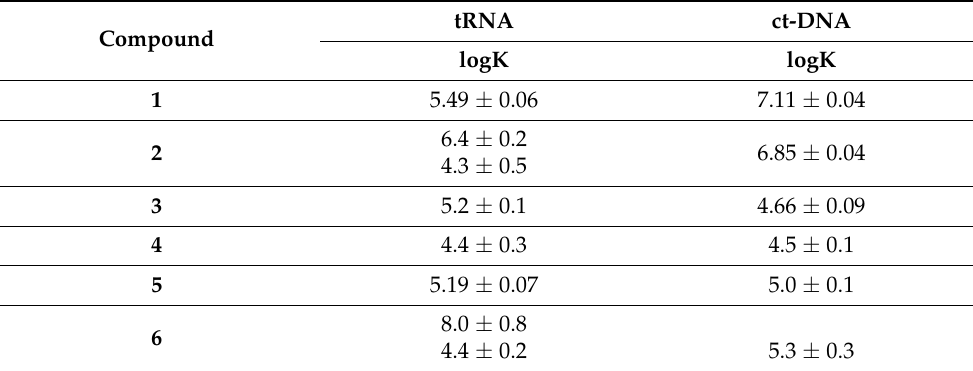
Table 2. Binding constants (logK) of compounds 1–6 with tRNA and ct-DNA calculated by processing fluorimetric